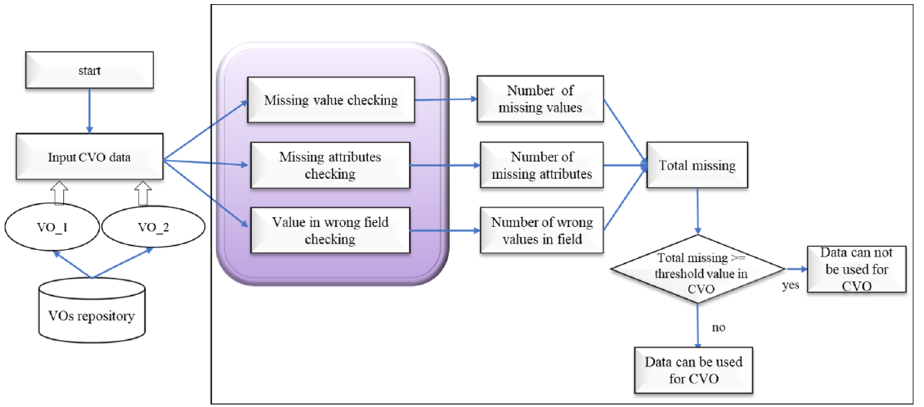
Figure 12. Completeness metric assessment.